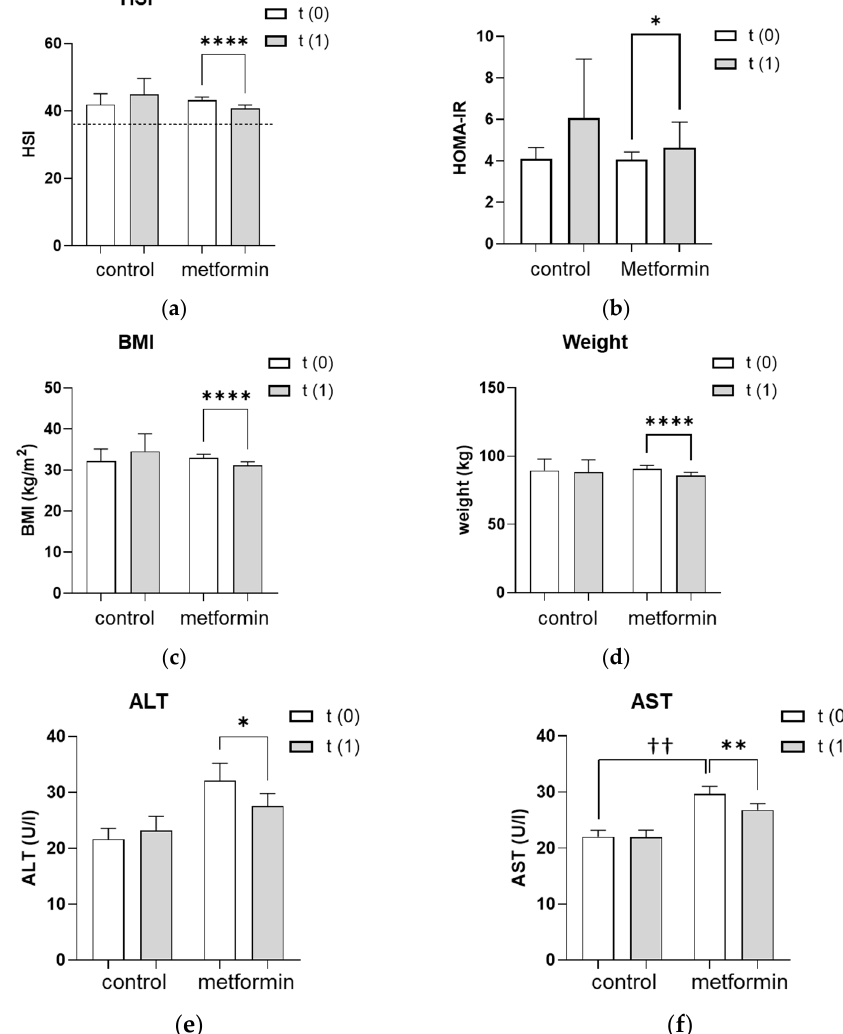
Figure 1. Effect of seven months of metformin treatment. ( a – f ) Metabolic and liver parameters were analyzed at baseline (t(0)) and after an average of seven months without (control) or with (metformin) metformin treatment (t(1)). ( a ) The dotted line represents the cutoff of 36 for a pathologic HSI. ( a – f ) Differences between characteristics in the metformin group vs. the control group were tested using the Mann–Whitney U for non-parametric tests. Differences between parameters at t(1) vs. t(0) were tested using Wilcoxon tests for paired non-parametric analyses. Data are presented as mean ± standard error of the mean. * p < 0.05, ** and †† p < 0.01, **** p < 0.0001. HSI: hepatic steatosis index, HOMA-IR: homeostatic model assessment for insulin resistance, BMI: body mass index, ALT: alanine transaminase, AST: aspartate aminotransferase.